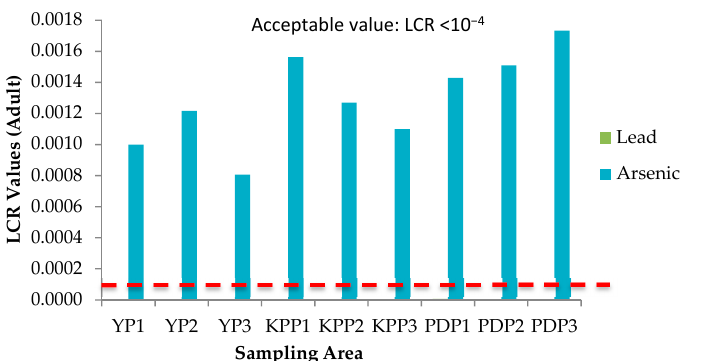
Figure 8. Hazard Index (HI) values of adults and children for three plots of Yan, Kubang Pasu, and Pendang. YP1: Yan Plot 1, YP2: Yan Plot 2, YP3: Yan Plot 3, KPP1: Kubang Pasu Plot 1, KPP2: Kubang Pasu Plot 2, KPP3: Kubang Pasu Plot 3, PDP1: Pendang Plot 1, PDP2: Pendang Plot 2, and PDP3: Pendang Plot 3.